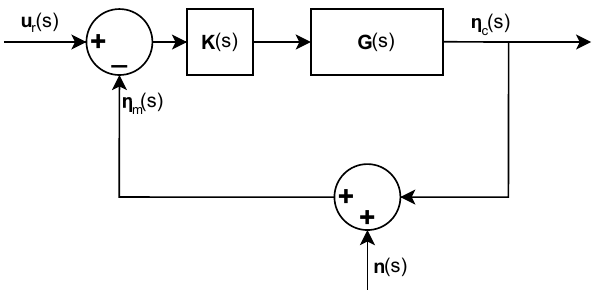
Figure 12. Block diagram showing the considered system including measurement noise